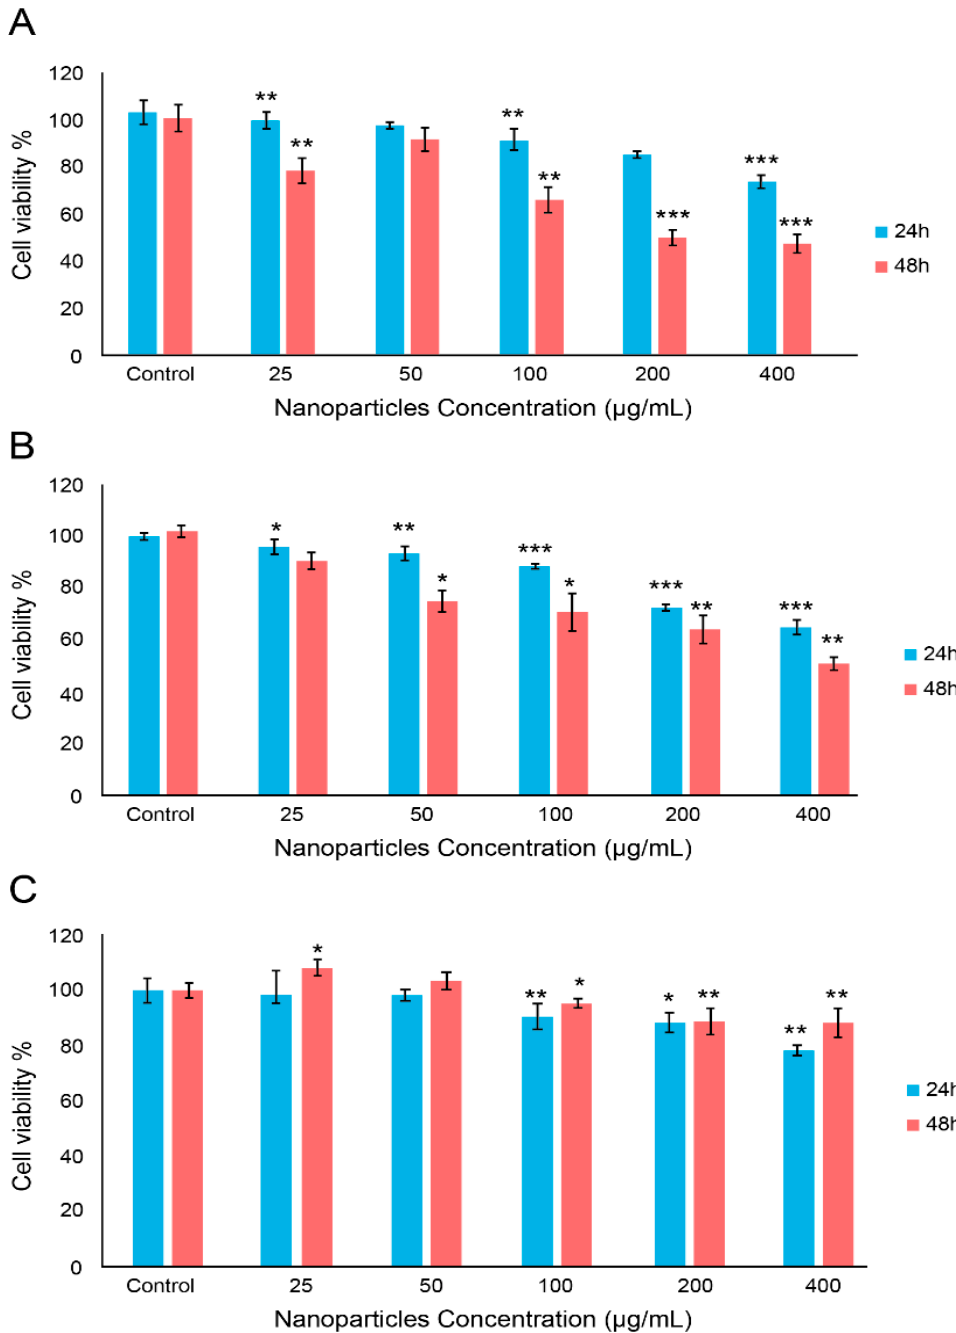
Figure 4. The percentage of viable cells of ( A ) HCT-166; ( B ) HELA; and ( C ) HFF-1 cells treated with synthesized poly (styrene–acrylic acid) latex particles at different concentrations. Data are the means ± standard deviation (SD). The t -test was performed on three independent sets of experiments conducted in triplicate. * p values < 0.05. ** p values < 0.01. *** p values < 0.001.